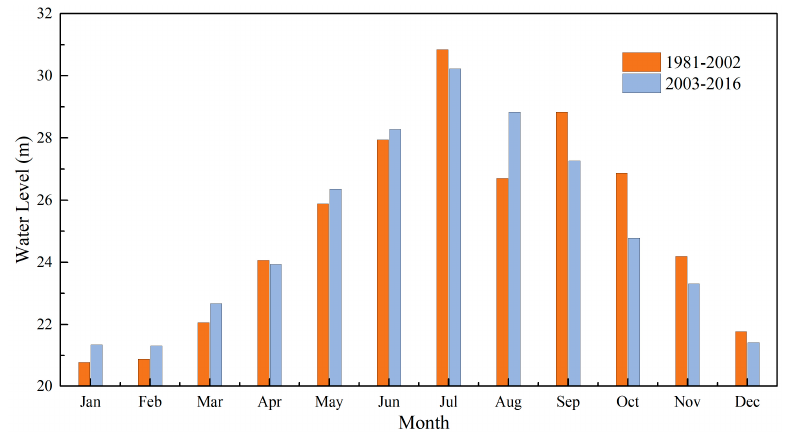
Figure 6. The average monthly water level in the two typical periods .